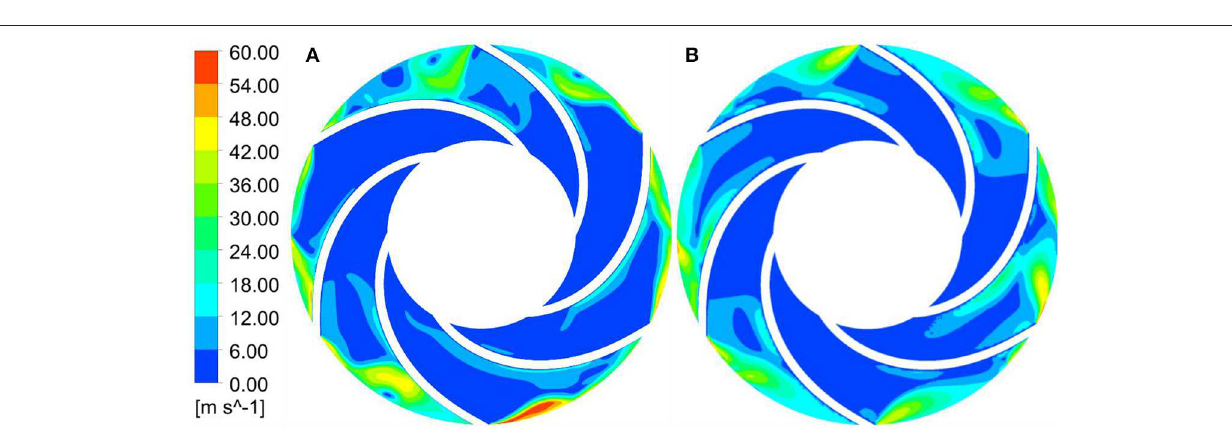
the increase of time, the speed of the impeller continuously increases, and the functional force for liquids also increases. The total mechanical energy converted into liquid also increases,